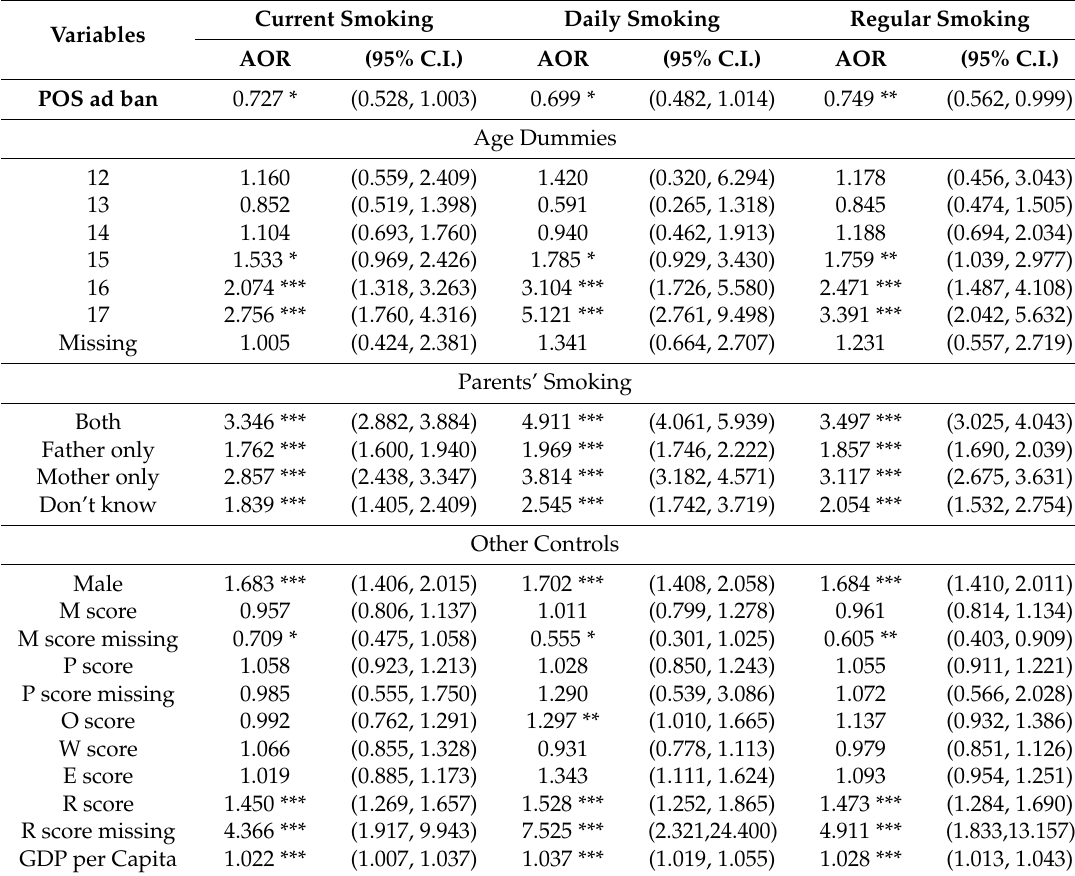
Table 3. Weighted logistic regressions, the association between POS ad bans and current smoking, daily smoking, and regular smoking